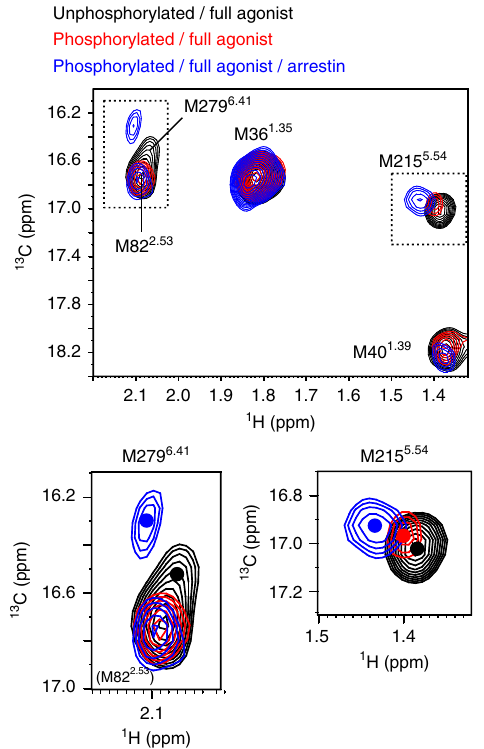
Fig. 5 Conformation of the TM region of the phosphorylated β 2 AR bound to β -arrestin. Overlay of the 1 H- 13 C HMQC spectra of [ 2 H-9AA, αβγ - 2 H, methyl- 13 C-Met] β 2 AR in rHDLs in the unphosphorylated state (black), phosphorylated state (red), and β -arrestin 1-bound state (blue). The centers of the resonances from M215 5.54 to M279 6.41 are indicated with dots. In the phosphorylated state, the resonance from M279 6.41 could not be